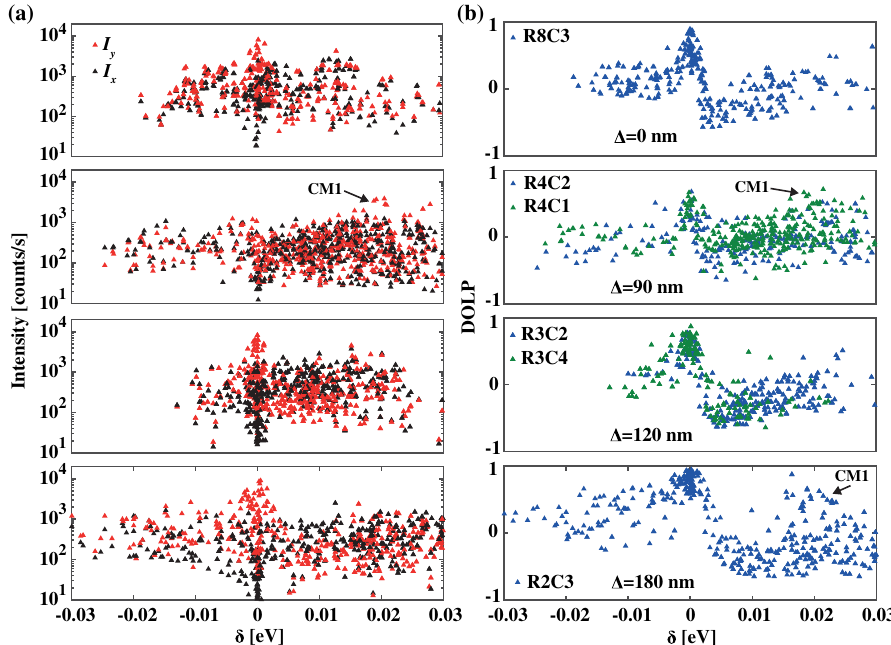
FIG. 13. Statistically yielded polarization-resolved intensities and DOLP spectra. (a) Polarization-resolved intensities of individual lines for Δ ¼ 0 , 90, 120, and 180 nm in an L 3 PC cavity. (b) DOLP values extracted from (a). Measurements were performed at 10 K temperature under 300 μ W excitation